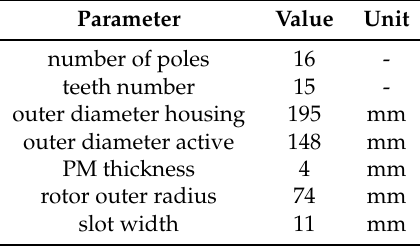
Table 2. YASA geometrical